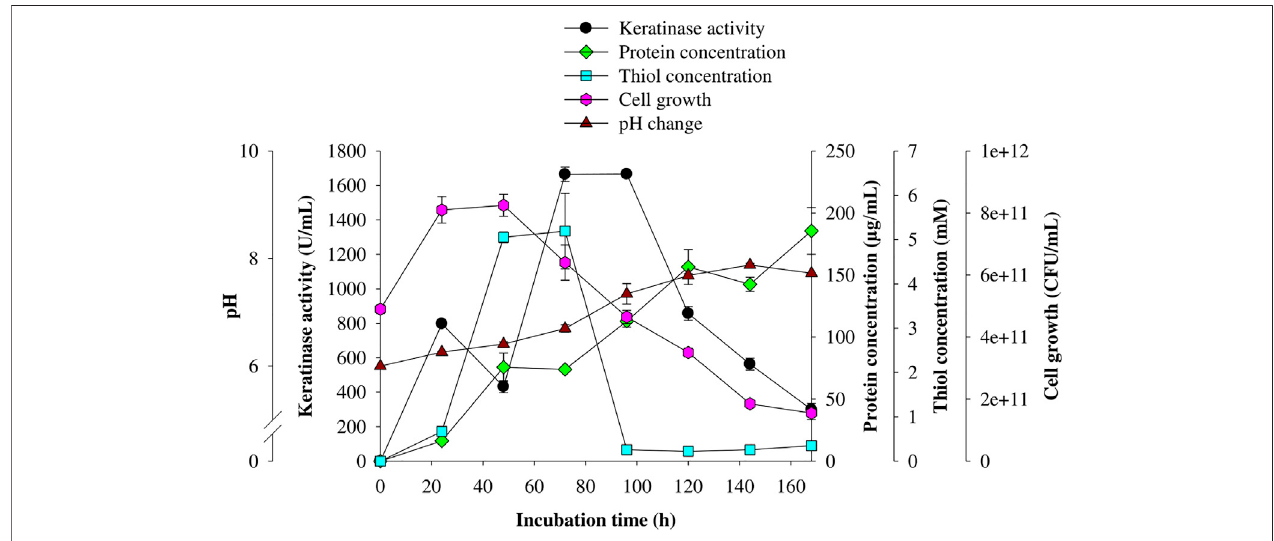
FIGURE 2 | Time course pro fi le of keratinolytic activity of C. aquifrigidense FANN1. The fermentation was carried out at optimal process conditions, and the experiment was performed in triplicate.